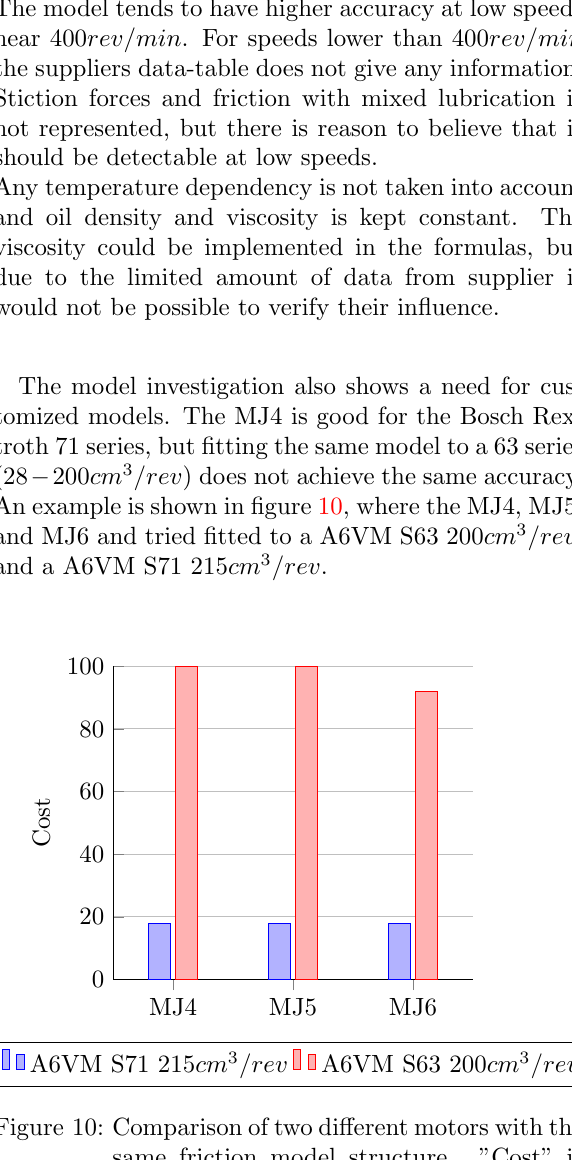
Figure 9: Error between model for low displacement settings, MJ4, and the performance data from supplier. Error is measured as a per- centage of the nominal motor torque. The comparison is performed at ∆ p m = 100 bar ∆ p m = 200 bar and ∆ p m = 300 bar .